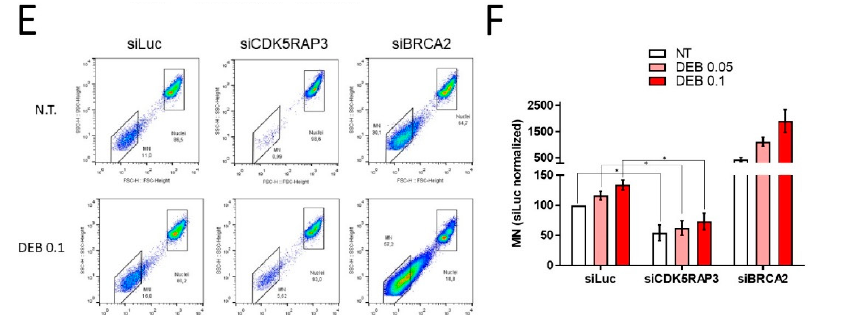
Figure 3. CDK5RAP3 regulates DSB DNA repair and genomic instability by homologous recombi- nation and single-strand annealing. ( A ) Diagrams showing the in vitro homologous directed and single-strand annealing repair assays (see materials and methods). In the DR-GFP system (upper diagram), U2OS cells carry a plasmid inserted in the genome with two adjacent non-functional GFP coding fragments, one of them with an I-SceI restriction site. When a plasmid expressing I-SceI endonuclease is transfected, a specific DSB is generated in one GFP coding fragment, promoting recombination with the adjacent fragment and the formation of a full, functional GFP coding sequence resulting in fluorescent cells. In the SA-GFP system (lower diagram), U2OS or HeLa cells carry a plasmid inserted in the genome with two adjacent non-functional GFP coding fragments, one short 5 ′ fragment and a 3 ′ fragment, including one with an I-SceI restriction site. When a plasmid express- ing I-SceI endonuclease is transfected, a specific DSB is generated in the 3 ′ GFP coding fragment, and a full, functional GFP coding sequence is formed after strand annealing, homolog searching and fusion with the 5 ′ GFP fragment. ( B ) Flow cytometry plots from DR-GFP (upper panels) and SA-GFP (bottom panels) in siRNA-transfected U2OS cells. ( C ) Averaged graph from at least four independent experiments of DR-GFP U2OS cells. GFP-transfected cells were used to normalize transfection effi- ciency. ( D ) Averaged graph from at least four independent experiments of SA-GFP in U2OS cells. ( E , F ) CDK5RAP3 inhibition reduces spontaneous and DNA damage-induced genomic instability. siRNA-transfected U2OS cells were plated and treated with ICL inducer DEB at different doses, and 72 h later samples were processed for the FCM assay and analyzed by cell cytometry (see materials and methods and Supplementary Figure S2A). ( E ) Representative experiment of the FCM assay in U2OS cells. Shown are FACS plots of nuclei and micronuclei (MN). ( F ) Averaged graph from at least four independent experiments performed as in ( E ) and normalized to luciferase control samples. Graph bars from ( C , D , F ) show mean ± SEM. * p < 0.05 ** p < 0.01 *** p